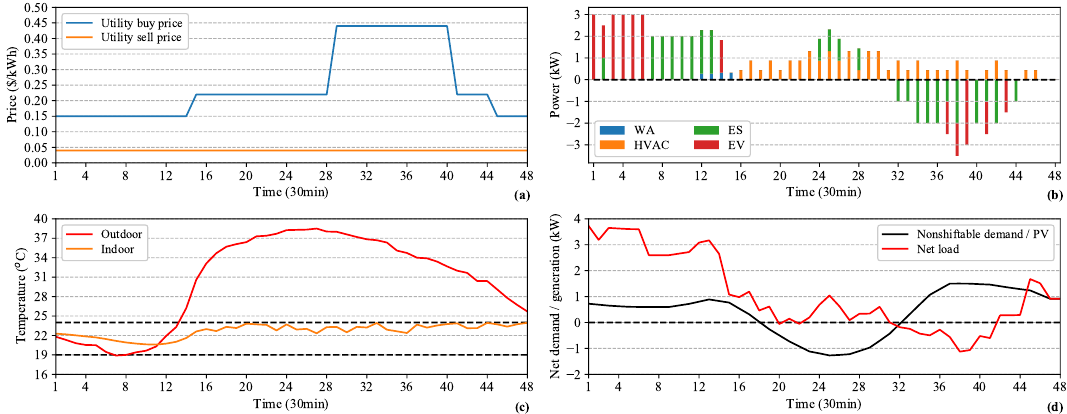
Figure 8. ( a ) Utility buy and sell prices, ( b ) aggregated schedule of flexible DERs, ( c ) indoor and outdoor temperature, and ( d ) net demand/generation of the household with/without flexible DERs for the investigated summer day under the deep Q network (DQN)